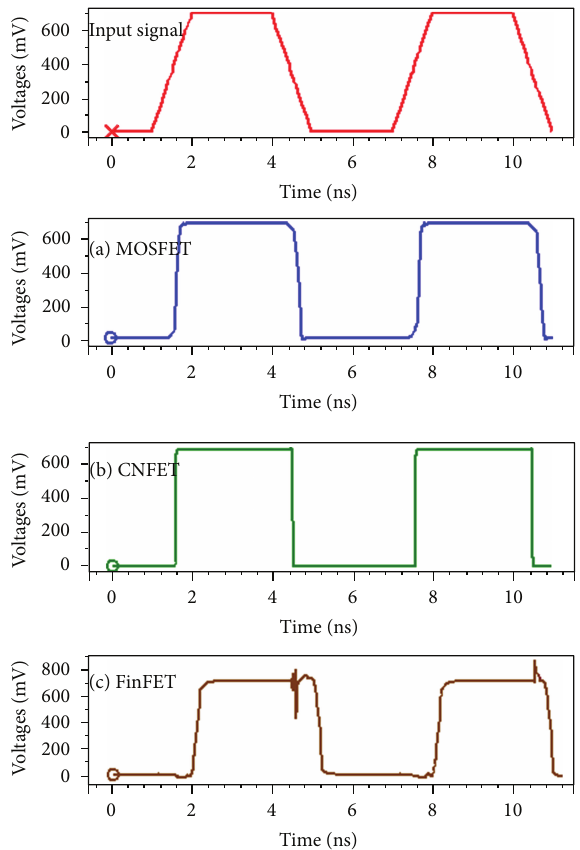
Figure 7: Buffered delay output waveform of proposed circuit realized using (a) MOSFETs, (b) CNFETs, and (c) FinFETs.